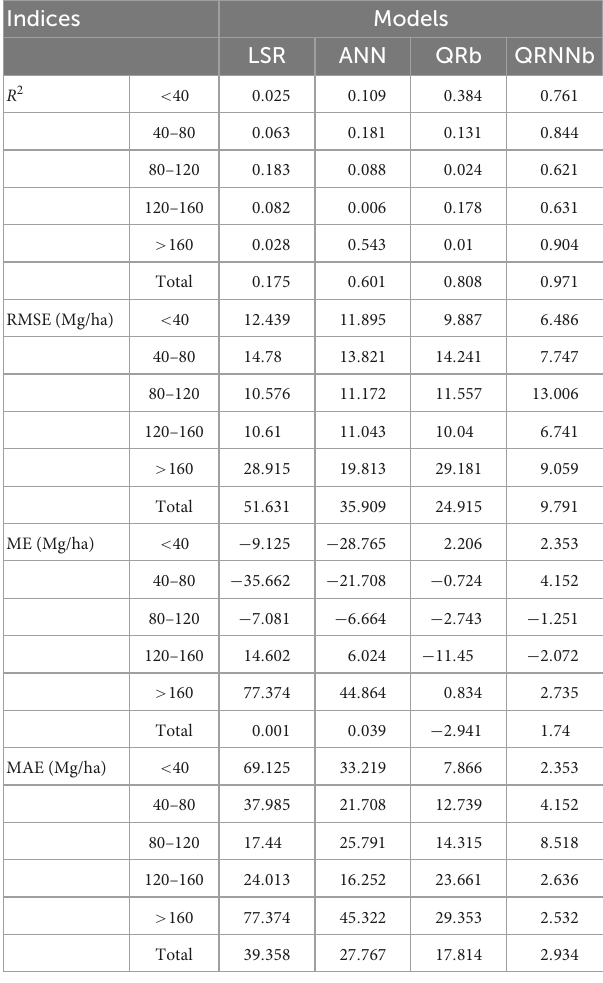
TABLE 5 Model validation results using the test dataset ( n =